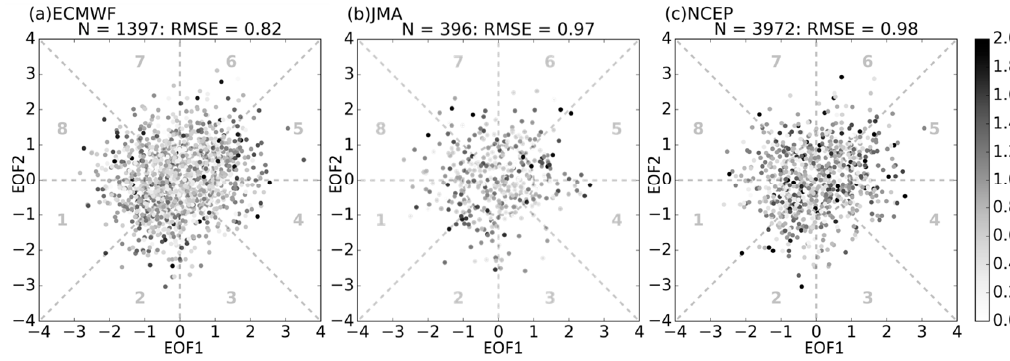
Figure 4. The error vector at 10-day lead time averaged over forecasts initially located in each MJO phase for ( a ) ECMWF, ( b ) JMA and ( c ) NCEP models. The magnitude of the error vector is as measured by the scale (bottom left).